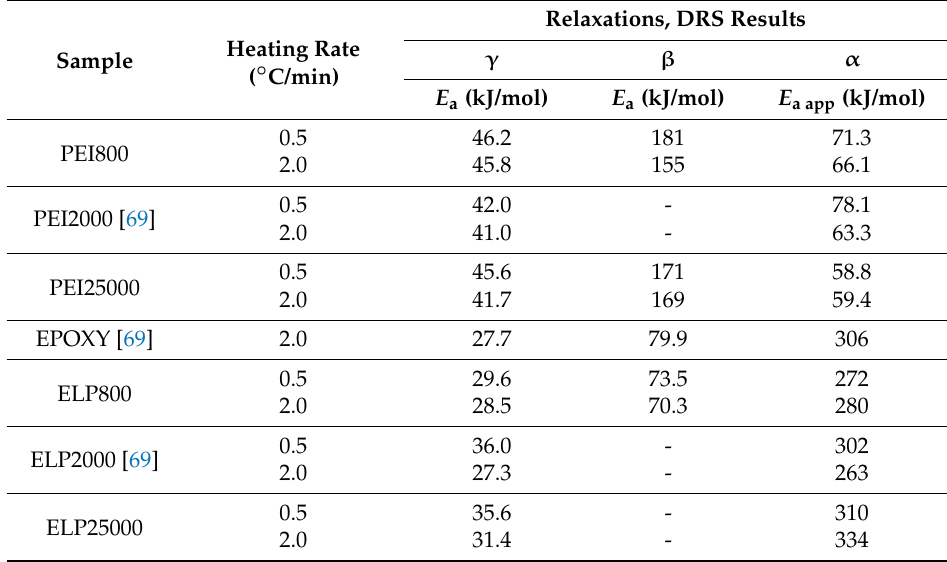
Table 3. Results of the analysis of dielectric measurements, DRS, for the different samples studied: HBPEIs, epoxy, and uncured ELP systems.